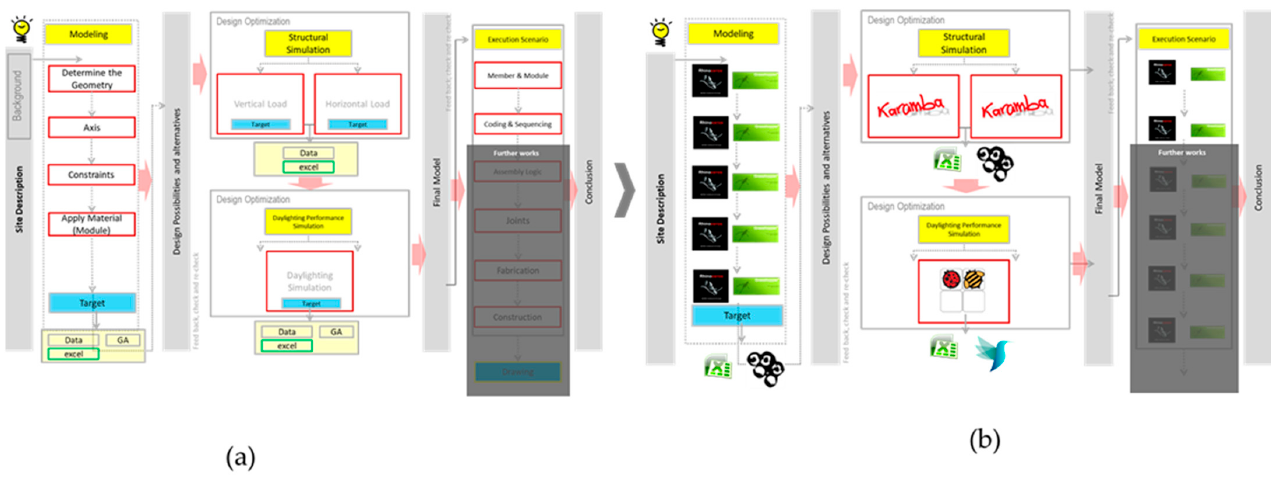
Figure 4. The scheme of the entire system: ( a ) geometry and analysis; ( b ) tools used.